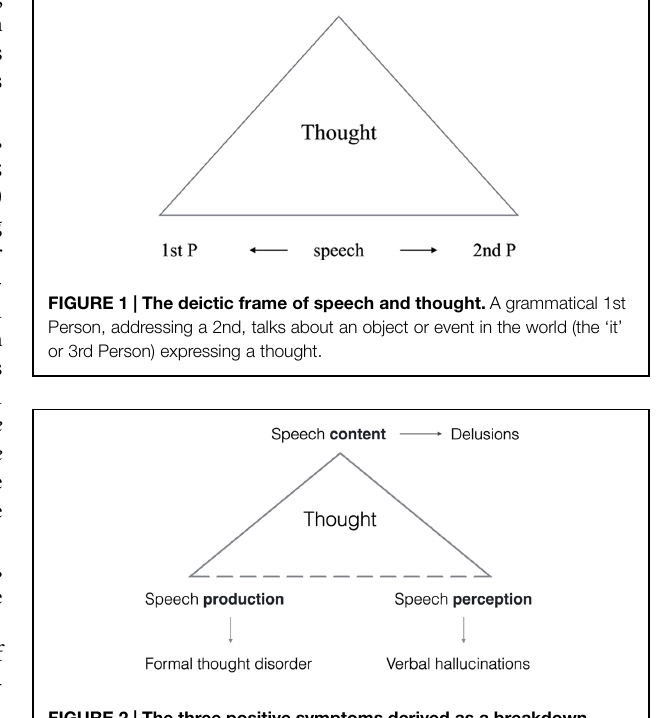
(cid:129) A disorder of speech production leading to disordered